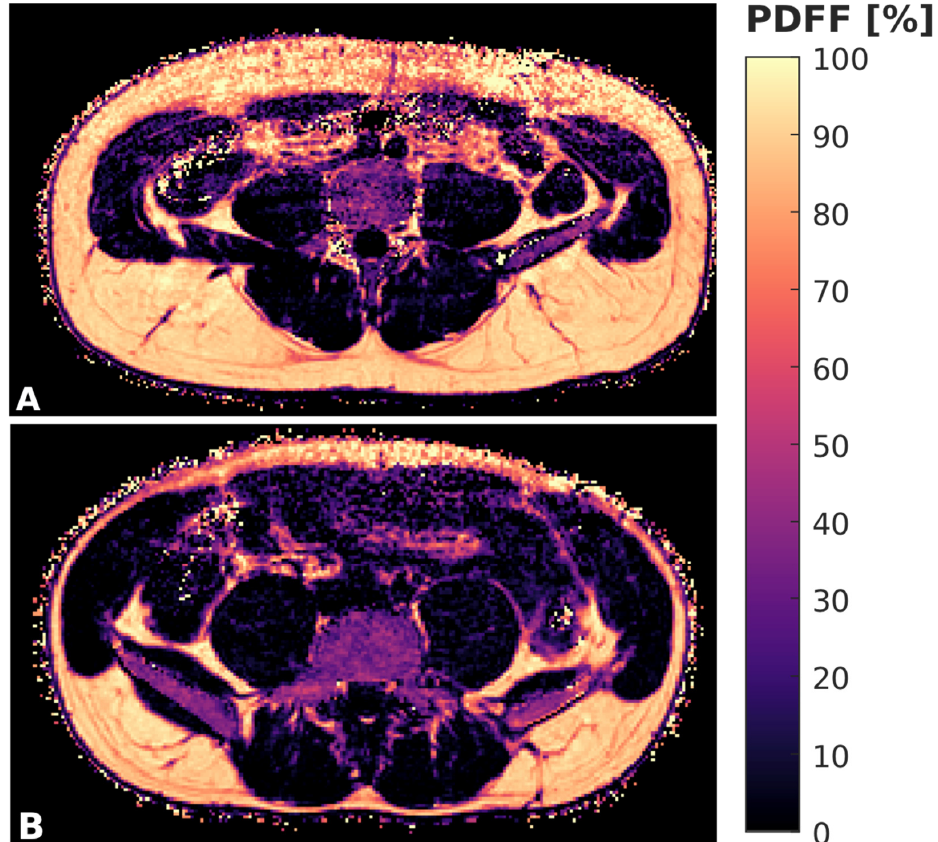
Figure 1. Color-coded, axially acquired PDFF maps derived from CSE-MRI of a 33 year old male ( A ) and 27 year old female ( B ) subject.